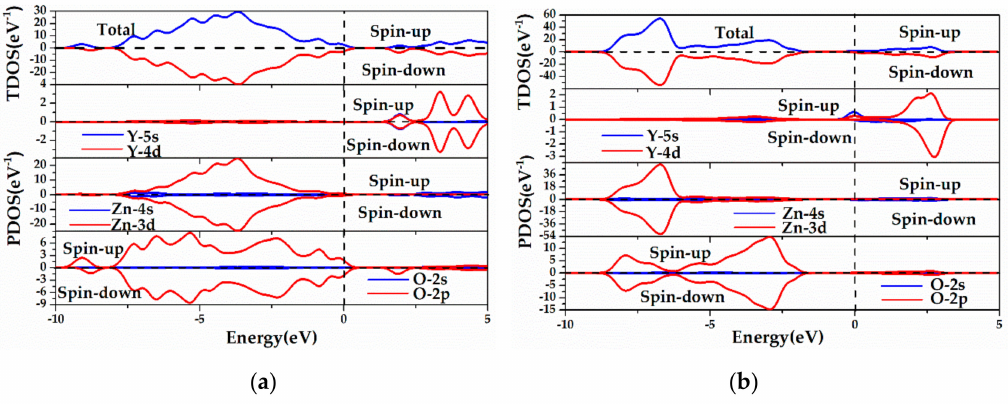
Figure 7. The calculated TDOS and PDOS of ( a ) Y-V Zn -ZnO, ( b ) Y-V O